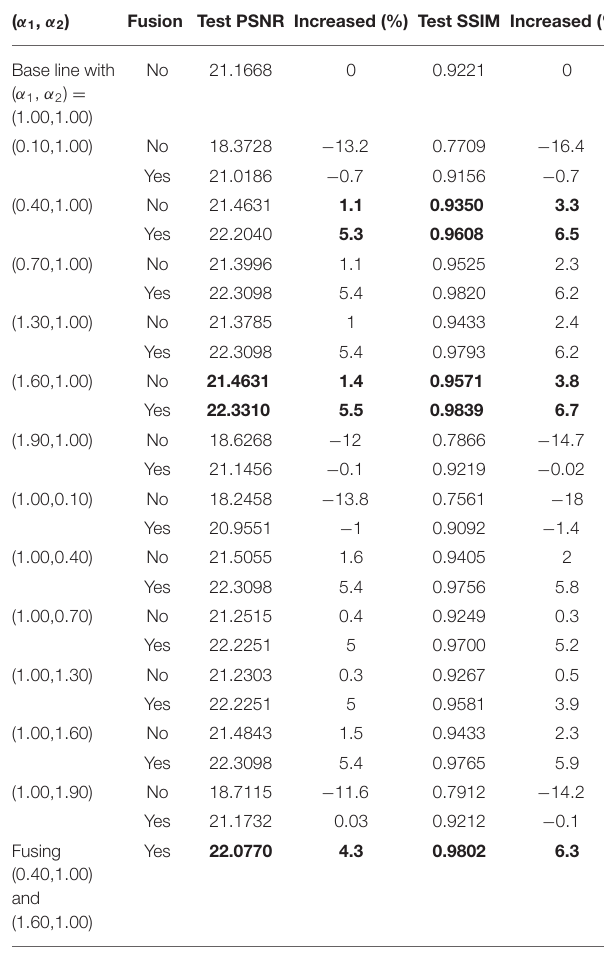
TABLE 5 | Results with FrScatNets on CelebA